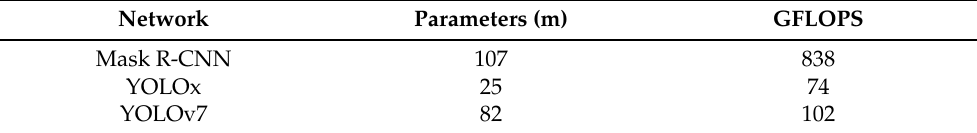
Table 2. Summary of memory and computation of models.